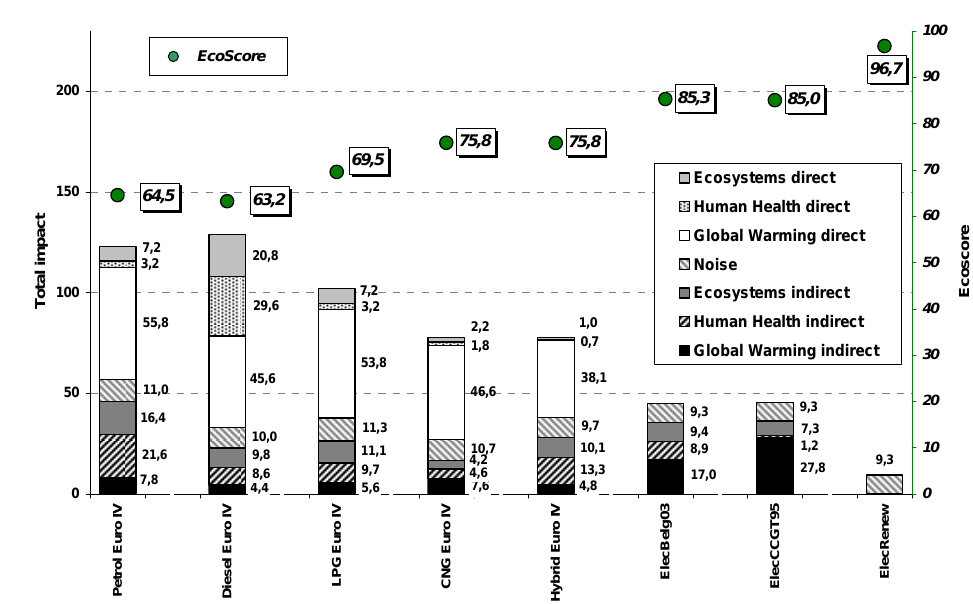
Figure 4. Total impact of different vehicle technologies and electricity production When comparing the results for an electric vehicle charged with electricity originating from a CCGT plant, with an electric vehicle charged using the Belgian electricity production mix, we can observe an important difference in the exhaust of green house gasses. It’s important to notice that the Belgian production park contains nuclear power plants delivering around 45% plants with new and highly efficient CCGT plants will alter the composition of